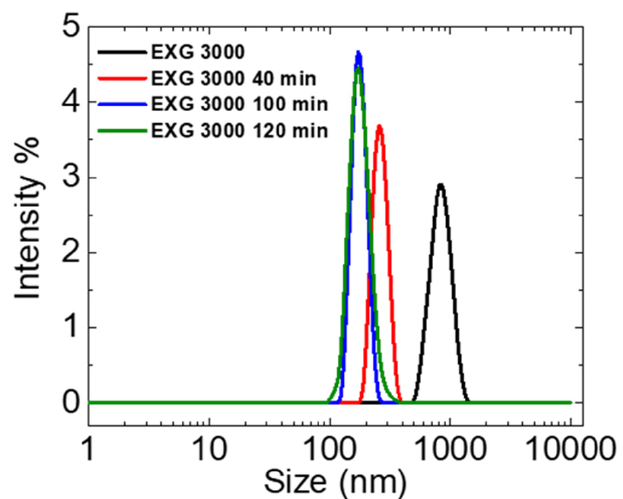
Figure 2. Dynamic light scattering (DLS) spectra of the ultrasonicated EXG 3000 samples and of pristine EXG 3000.